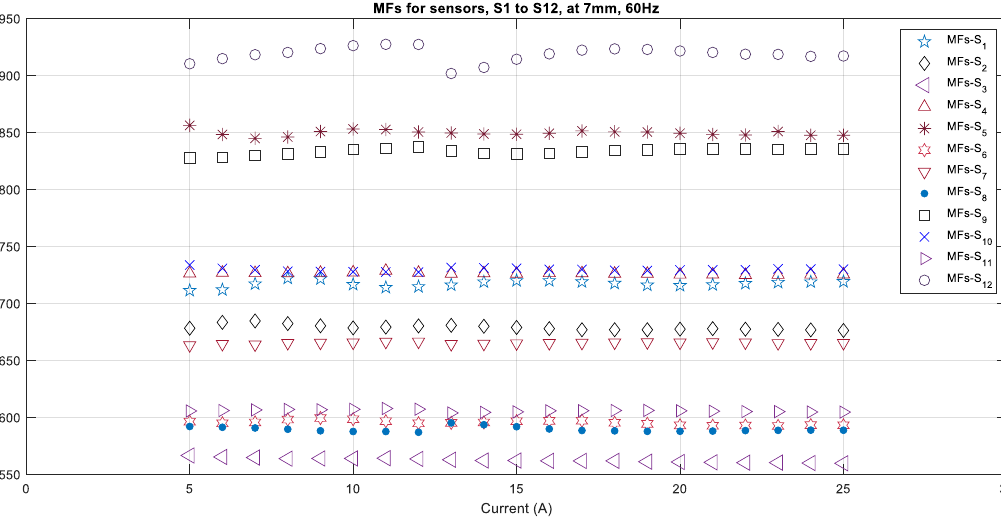
Figure 4. Multiplying actors for all sensors for case of 7 mm, 60 Hz.